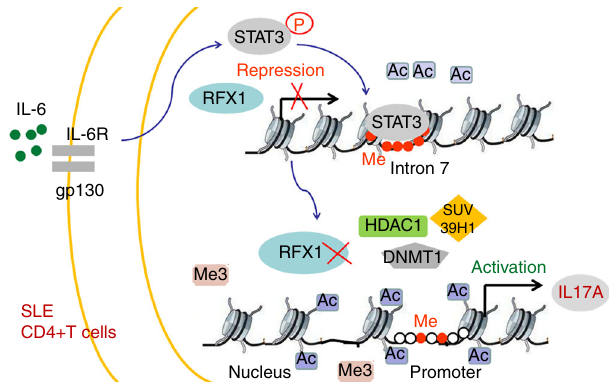
Fig. 10 Model of an atypical IL-6-Stat3-RFX1-IL-17A regulatory pathway in CD4 + T cells of SLE patients. IL-6 stimulation causes the phosphorylation of STAT3, which binds intron 7 of RFX1 to repress RFX1 gene transcription through increased DNA methylation and decreased histone